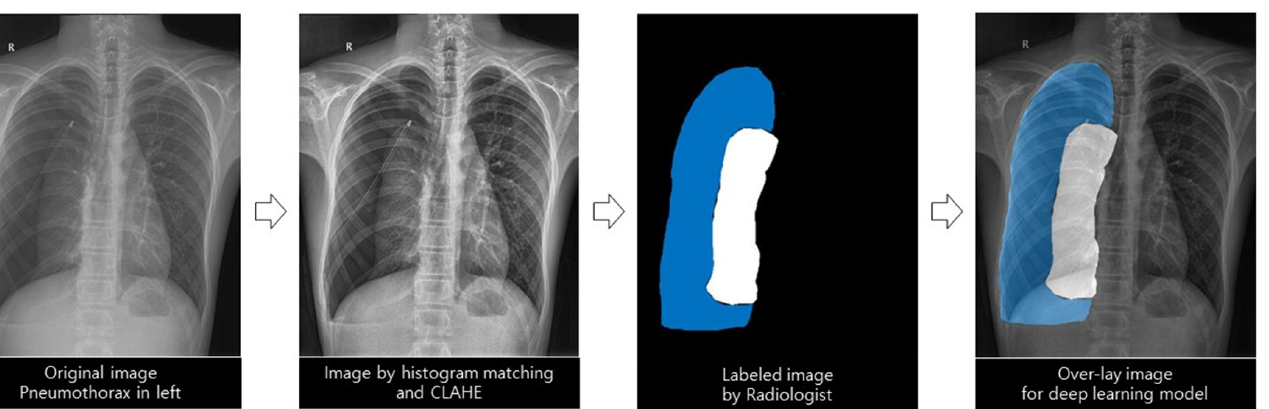
Figure 1. Schematic of AI modeling study for the measurement of pneumothorax. ( A ) A deep learning framework using the U-Net architecture segmented lung and pneumothorax on chest ra- diographs; ( B ) Quantitative value of pneumothorax was calculated using the predicted label; ( C )